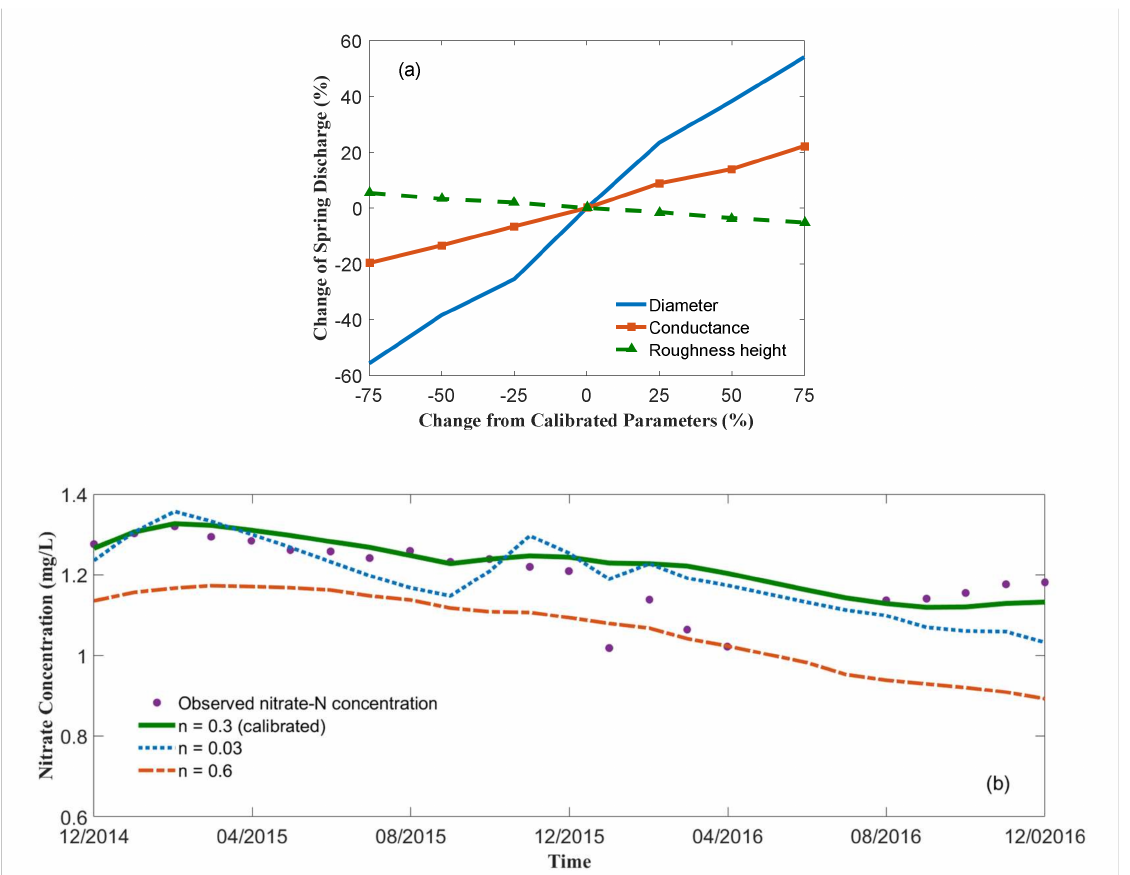
Figure 10. ( a ) Discharge sensitivity to pipe diameter, pipe conductance, and roughness height; ( b ) sensitivity of nitrate-N concentration in spring discharge to